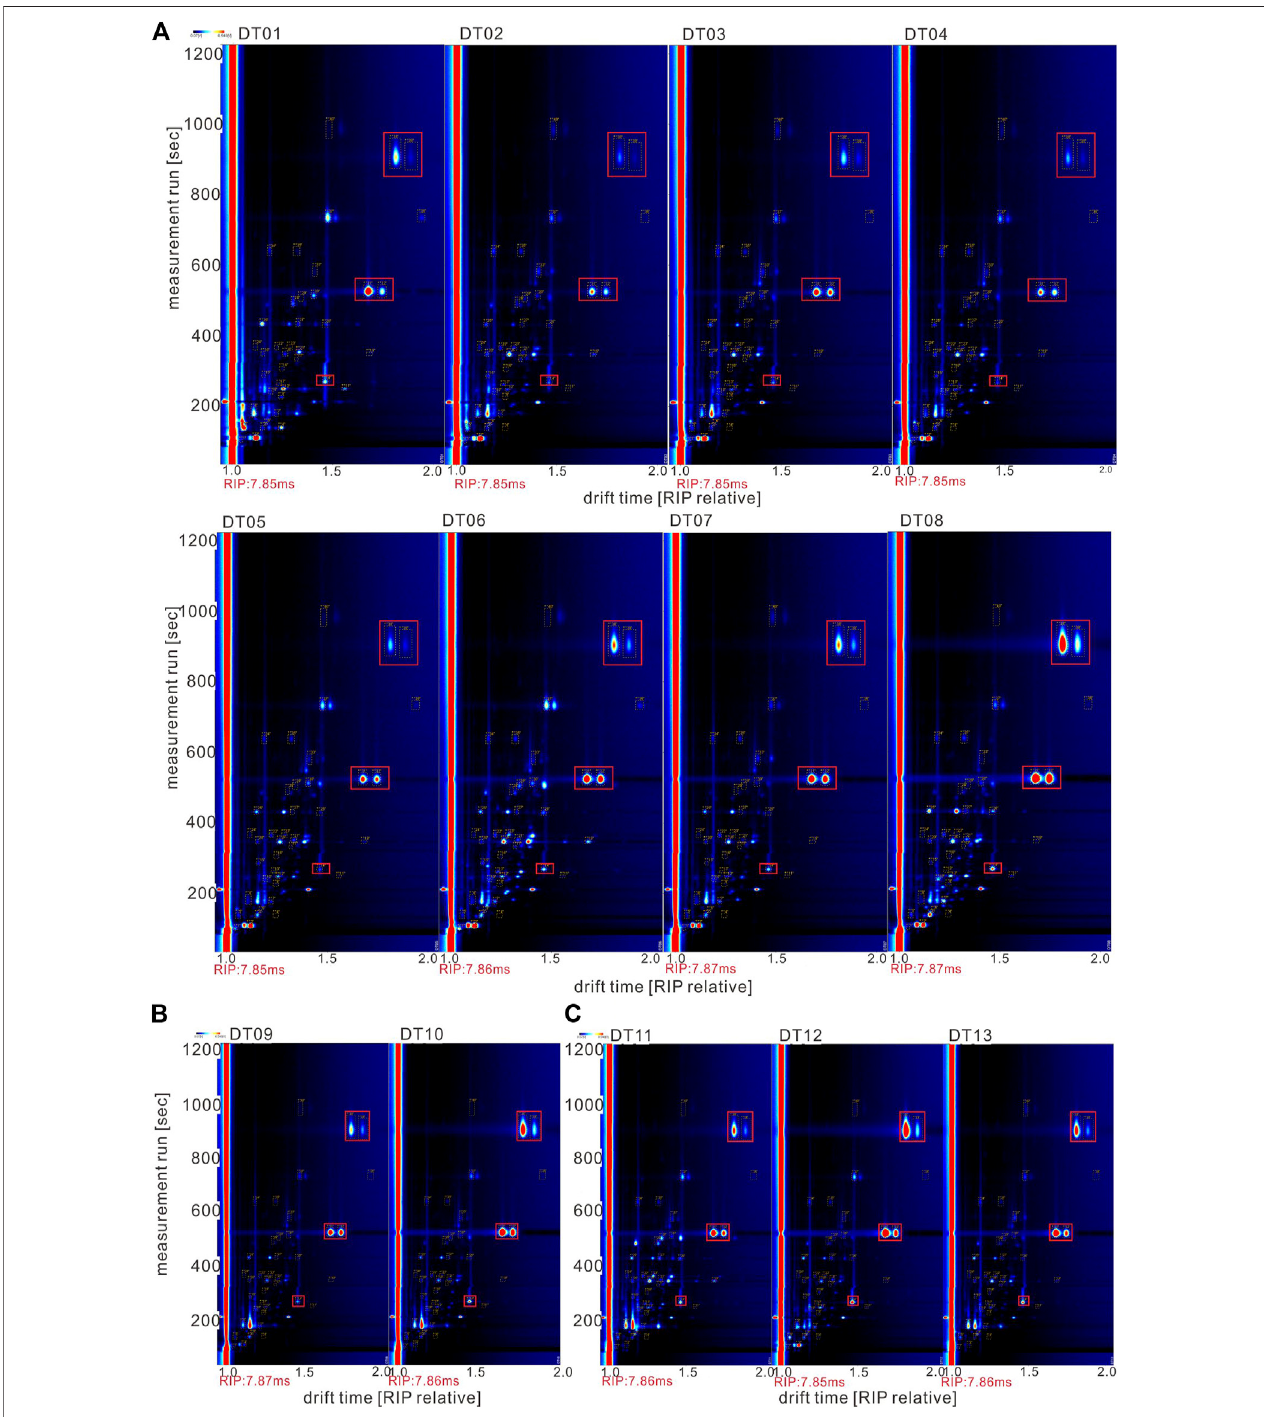
FIGURE 3 | HS-GC-IMS topographic plots of different samples: (A) : clay (DT01 – DT08); (B) : sandstone (DT09 – DT10); and (C) : halite (DT11 – DT13).